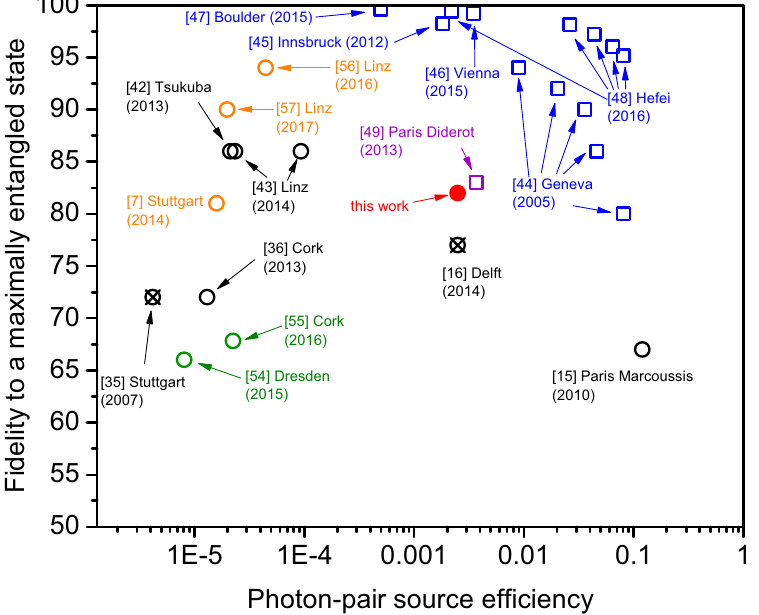
Figure 6. Comparison of the entanglement fidelity and photon-pair source eficiency of different parametric down-conversion (squares) and quantum dot-based (circles) pulsed entangled photon-pairs sources. The photon-pair source efficiency is defined as the probability per excitation pulse to collect a photon pair at the first lens or fiber. Note that the fidelity of the quantum dot-based sources is calculated for the non post-selected case, where all emitted photons are taken into account. For the quantum dot sources, the black color corresponds to above-band excitation, the green color to electrical excitation, the orange color represents resonant biexciton excitation, and the red color indicates quasi-resonant excitation. The crossed black circles symbolizes aboveband excited sources which have also been measured under quasi-/resonant excitation conditions. References of the depicted data points are given in brackets next to the